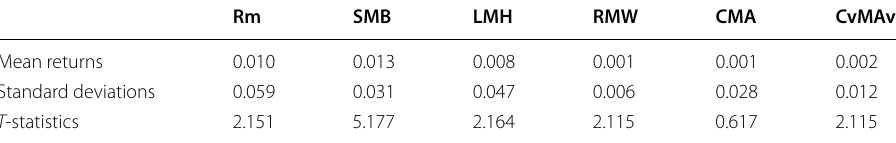
Table 1 Descriptive statistics for the independent variables Rm SMB LMH RMW CMA CvMAv Mean returns 0.010 0.013 0.008 0.001 0.001 0.002 Standard deviations 0.059 0.031 0.047 0.006 0.028 0.012 T -statistics 2.151 5.177 2.164 2.115 0.617